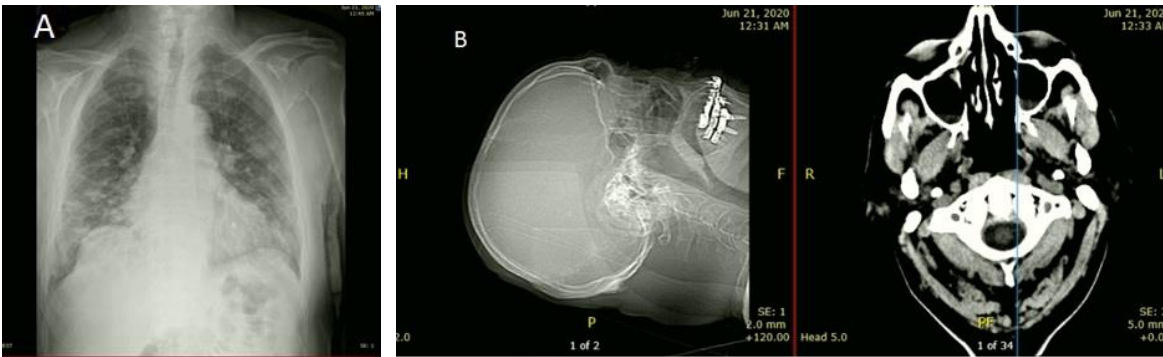
Figure 1. ( A ) Chest X-ray depicting bilateral multifocal patchy opacity more at lower zone and no cardiomegaly. ( B ) Brain CT scans showed no acute major infarction or